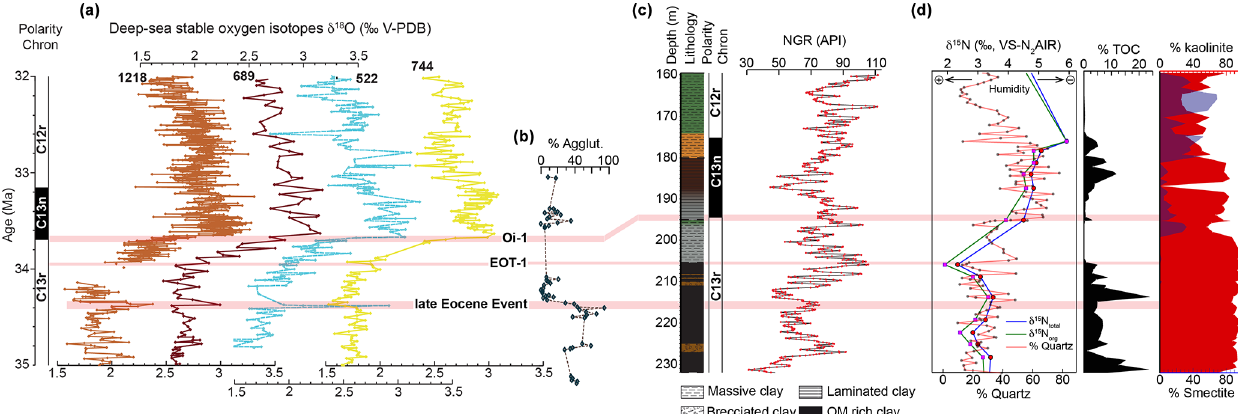
Figure 8. Correlation of the main changes in the sedimentary facies in the CDB1 core around the EOT and the main climatic (cooling/glacial) events recognized in deep-sea records (DSDP Site 522, ODP Sites 689, 744 and 1258). (a) Deep-sea δ 18 O data from multiple sites (indicated, Site 1218: Coxall and Wilson, 2011; Site 689: Diester-Haas and Zahn, 1996; Sites 522 and 744: Zachos et al., 1996) document successive glacial events: “late Eocene Event”, EOT-1 and Oi-1 related to the Antarctic Ice Sheet (Coxall and Wilson, 2011). (b) Agglutinated benthic foraminifera data at ODP Site 647 (Kaminski and Ortiz, 2014) against the age model of Coxall et al. (2018). (c) Lithostratigraphy, mag- netostratigraphy and NGR data around the Eocene–Oligocene boundary in the CDB1 core. (d) Terrestrial-derived organic nitrogen isotope record ( δ 15 N org ), quartz content, total organic carbon (TOC) content, kaolinite and smectite contents from Tramoy et al.